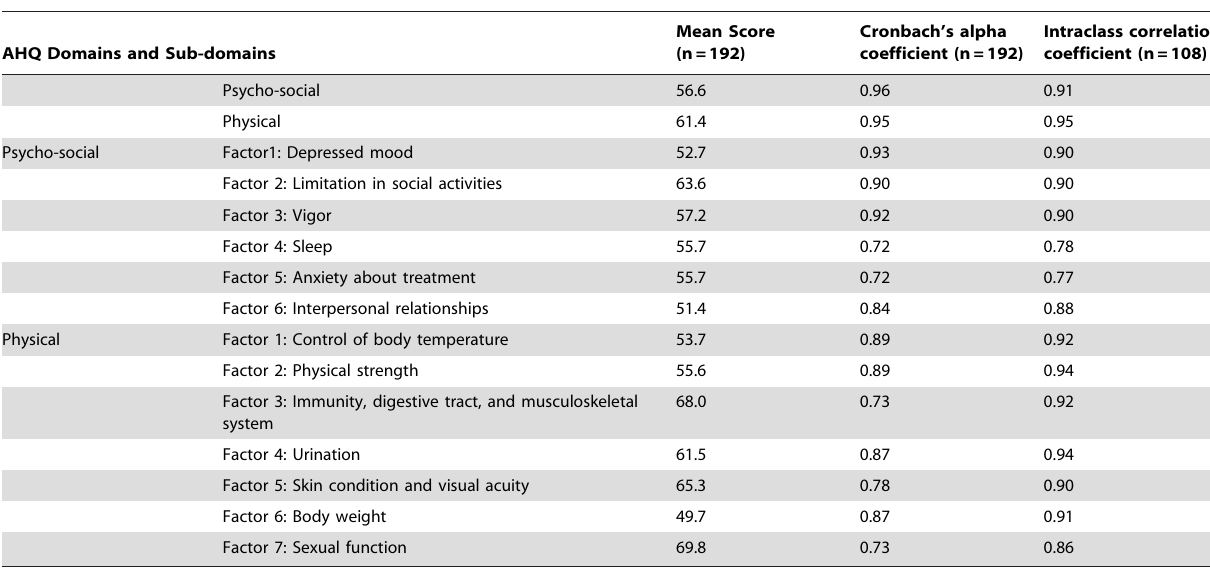
Table 3. Mean score, Cronbach’s alpha, and intraclass correlation coefficient.